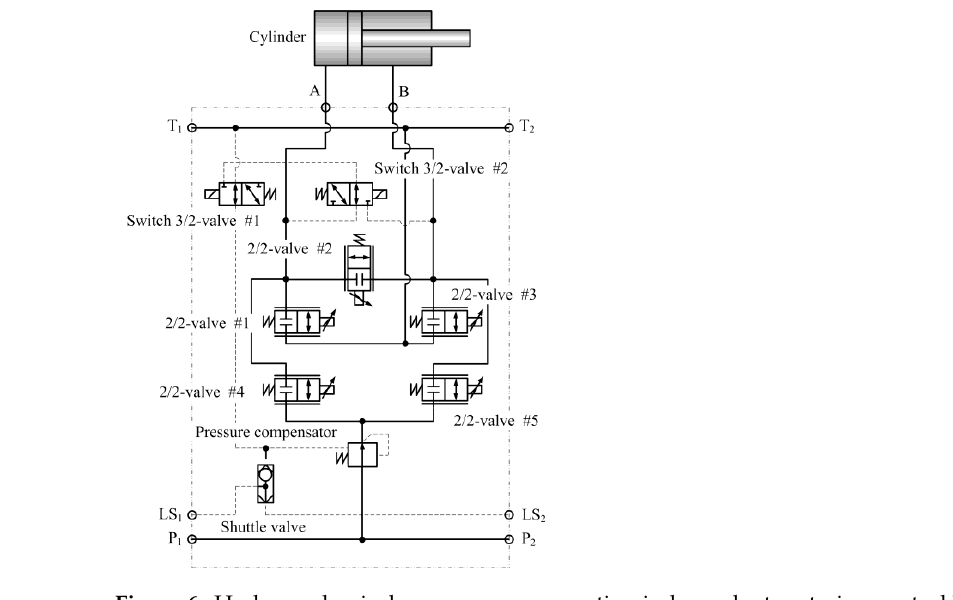
Figure 6. Hydromechanical pressure compensation independent metering control block controls a cylinder.